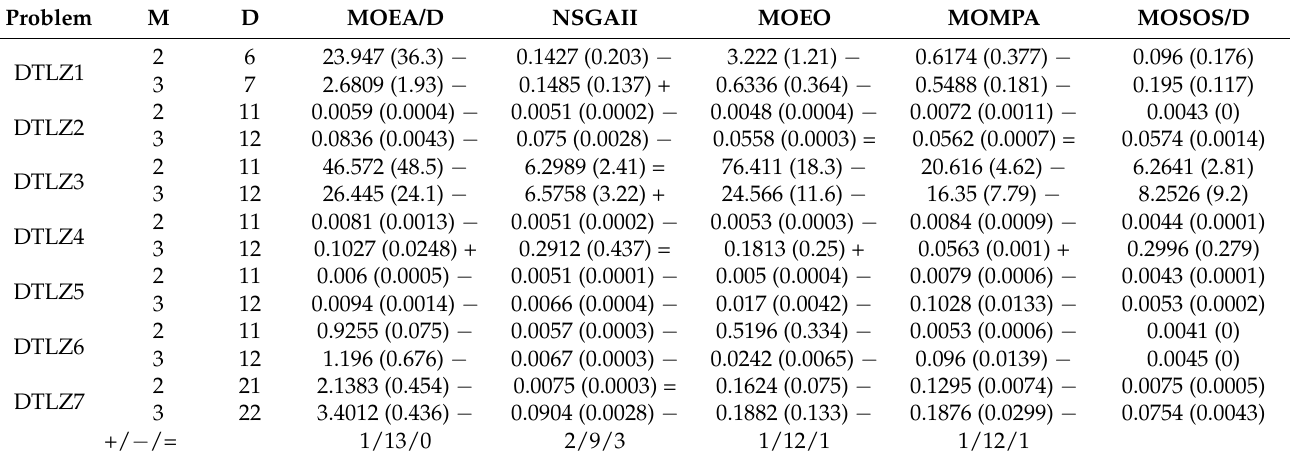
Table 4. The IGD (convergence and coverage) metric comparison.